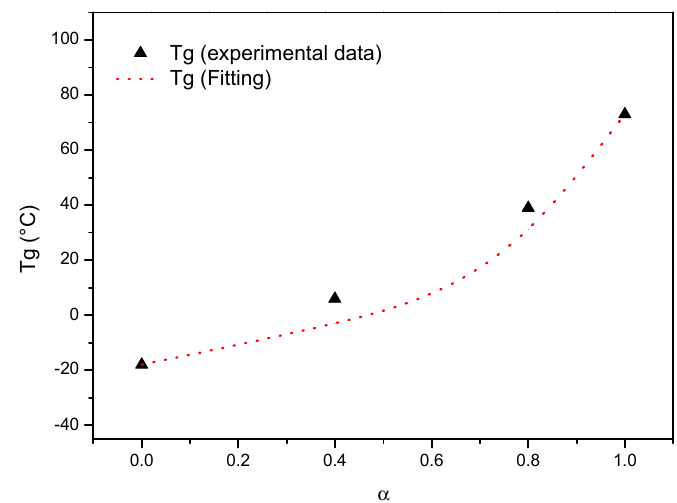
Figure 4. T g evaluation at different degrees of conversion (black triangles) and fitting with the Di Benedetto equation (dash red line).